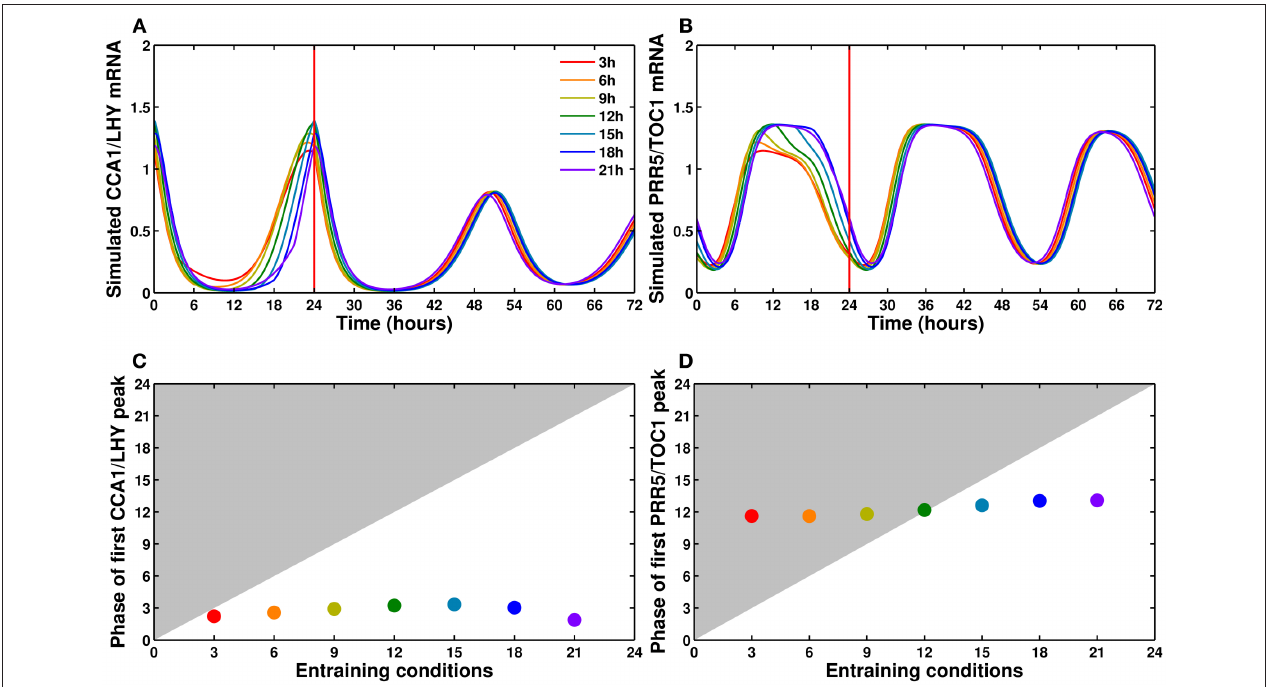
FIGURE 7 | CCA1/LHY and PRR5/TOC1 expression profiles in different photoperiods. (A,B) Simulated profiles of CCA1/LHY (A) and PRR5/TOC1 (B) : one cycle in photoperiods ranging from 3 to 21 h in increments of 3 h, followed by release into continuous light at time 24. The colors go from red for a 3 h photoperiod to purple for a 21 h photoperiod. The time of the first peak in free-running conditions is almost independent of the entraining photoperiod. (C,D) Relationship between the entraining photoperiod and the phase of the first free-running peak.